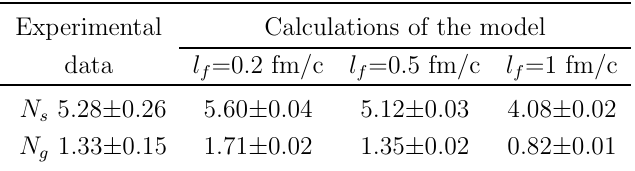
Table 2. The average multiplicities of s- and g-particles, produced in charged-current ν µ